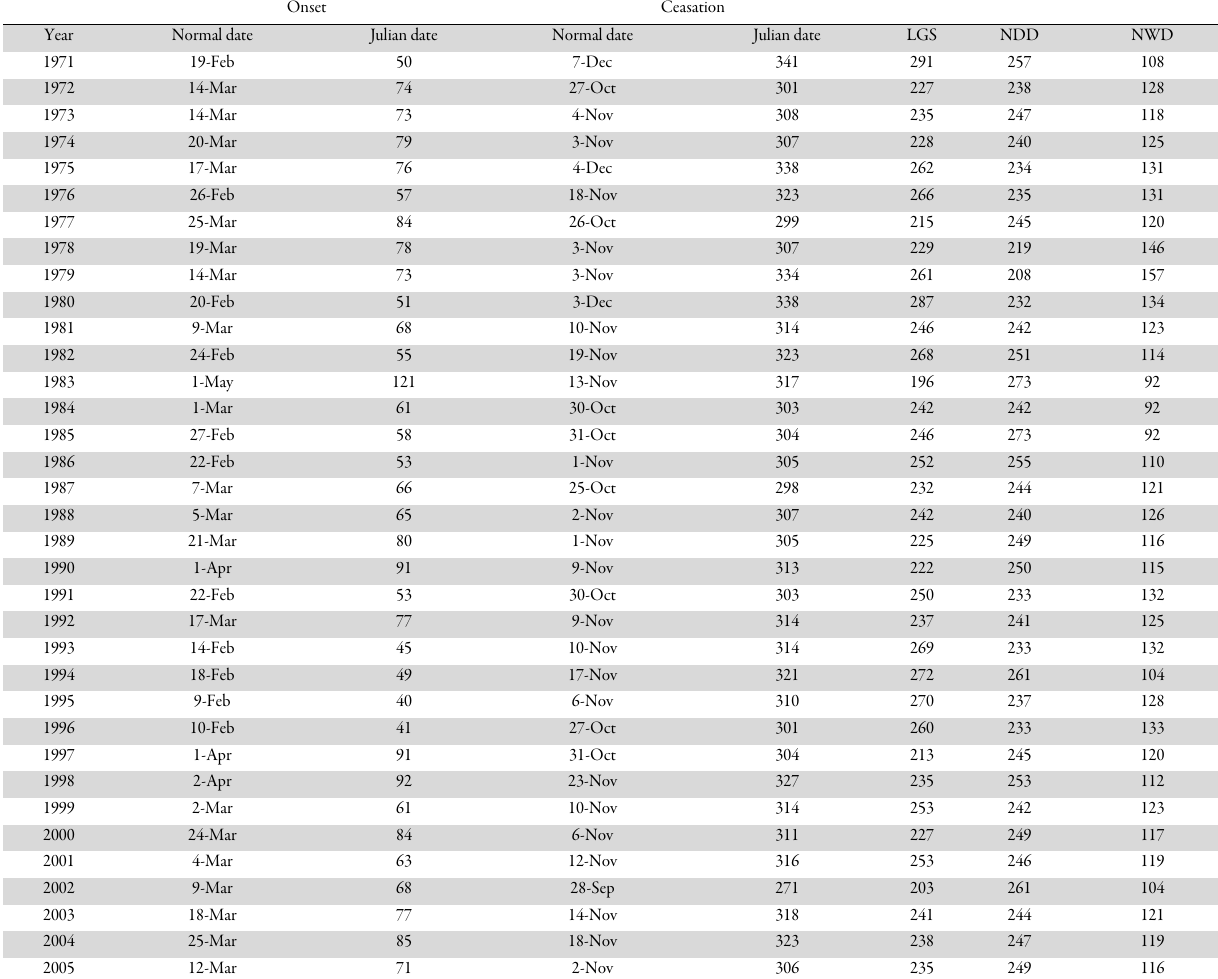
Table 2. Onset, cessation, length of growing season (LGS), number of dry days (NDD) and number of wet days (NWD) in Ondo Onset